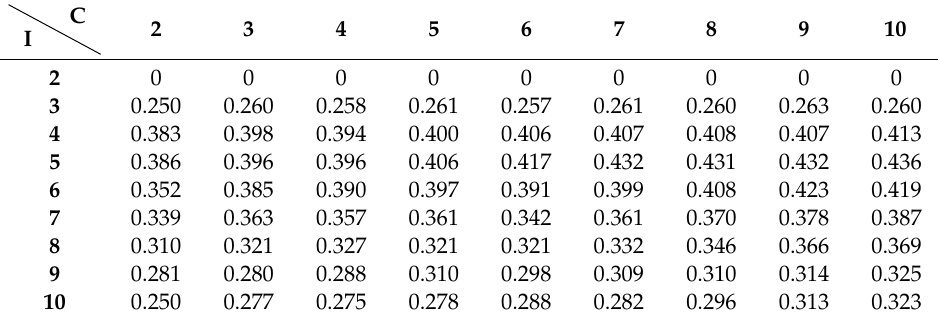
Table 5. CCS prediction results for interval-based IGM (Case 3) using training data.